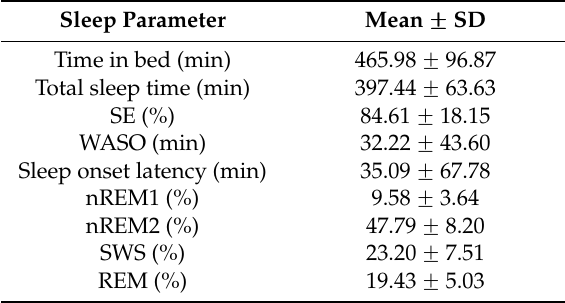
Table 3. Sleep characteristics based on polysomnography.